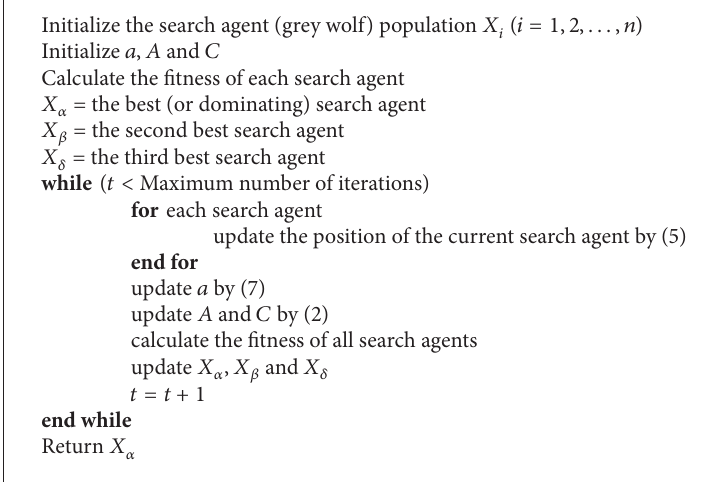
Algorithm 1: Pseudocode of mGWO algorithm.